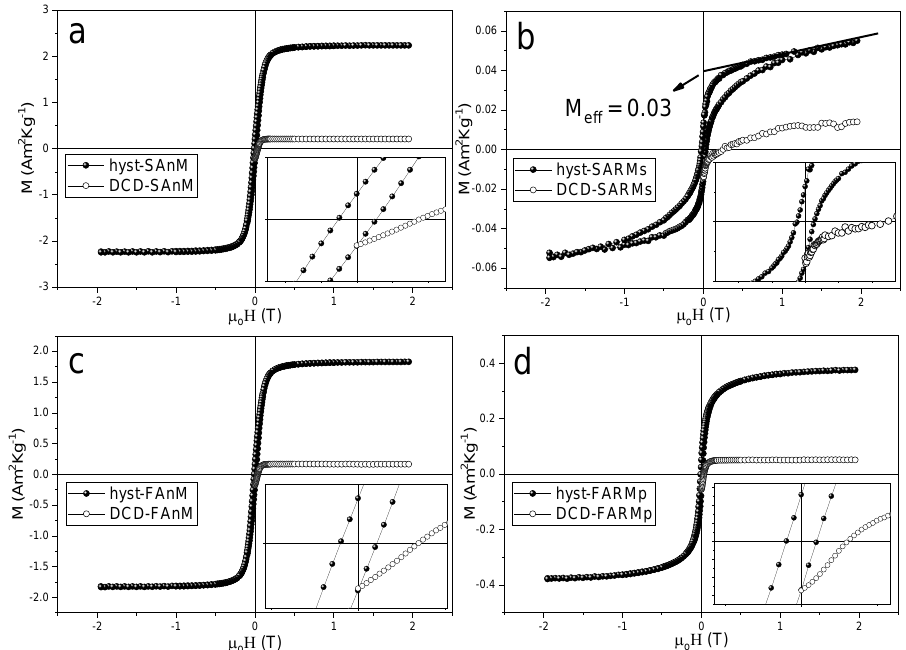
Figure 4. Room temperature hysteresis curves (full symbols) and DCD remanent magnetization curves (empty symbols) of ( a ) SAnM and ( b ) SARMs, ( c ) FAnM, and ( d ) FARMp. Table 1. Saturation Magnetization (Ms) coercive field (H c ) extracted from hysteresis recorded at 300 K. Remanence Coercivity (H Cr ) extracted from DCD recorded at 300 K. Uncertainties in the last digit are given in parentheses.